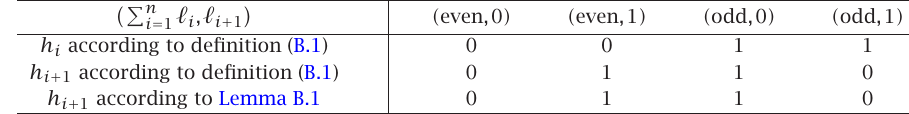
Table B.1 . Proof by cases of Lemma